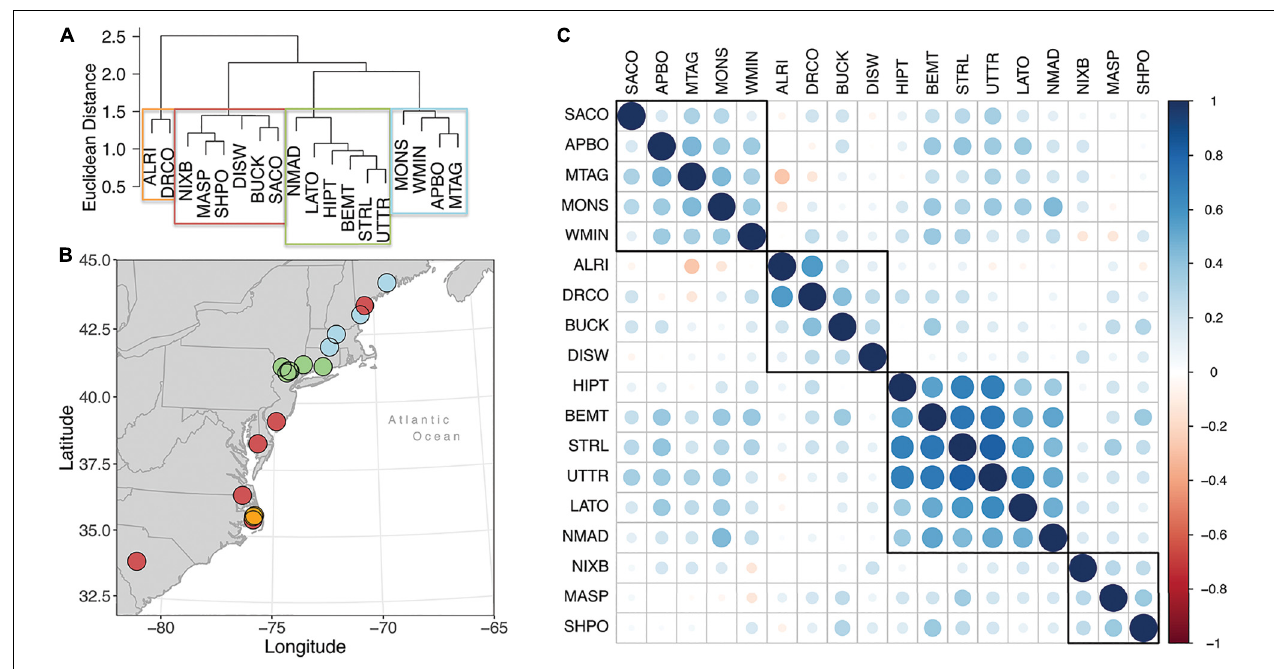
FIGURE 3 | (A) Hierarchical cluster analysis of population-level Chamaecyparis thyoides growth from 1940 to 2000. Final clustering was based on Euclidean distance and Ward’s minimum variance method. Boxes represent population classification based on a k-means cluster analysis, in which the network was partitioned into 4 groups (red, blue, green, orange). (B) Map illustrating the group classification for each population, with each color corresponding to the group shown in panel (A) . (C) Cross-correlation matrix, aka the correlogram, of the Chamaecyparis thyoides populations with each other, arranged from northern to southern ends of our network from left to right at the top of the matrix and top to bottom along the left-hand side of the matrix. Boxes identify clusters based on correlation and generally resemble the Hierarchical cluster analysis